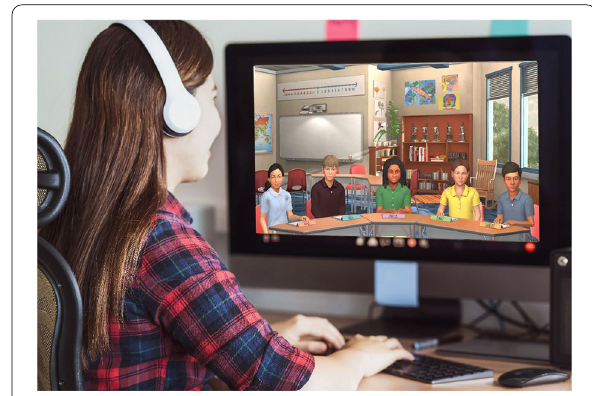
Fig. 1 Preservice Teacher Interacting with Student Avatars in the Simulated Classroom. Image courtesy of Mursion,